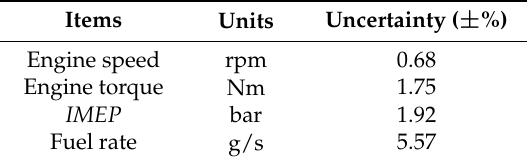
Table 3. Uncertainty in the experimental results of the engine test. IMEP : Indicated mean effective